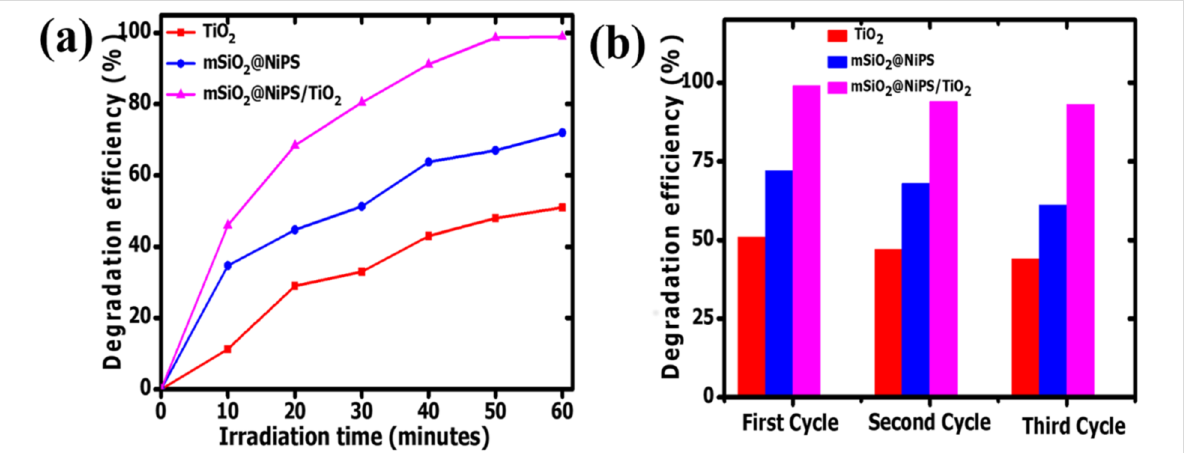
Figure 5: (a) The photocatalytic degradation of MV solution and (b) recyclability test for TiO 2 , mSiO 2 @NiPS, and mSiO 2 @NiPS/TiO 2